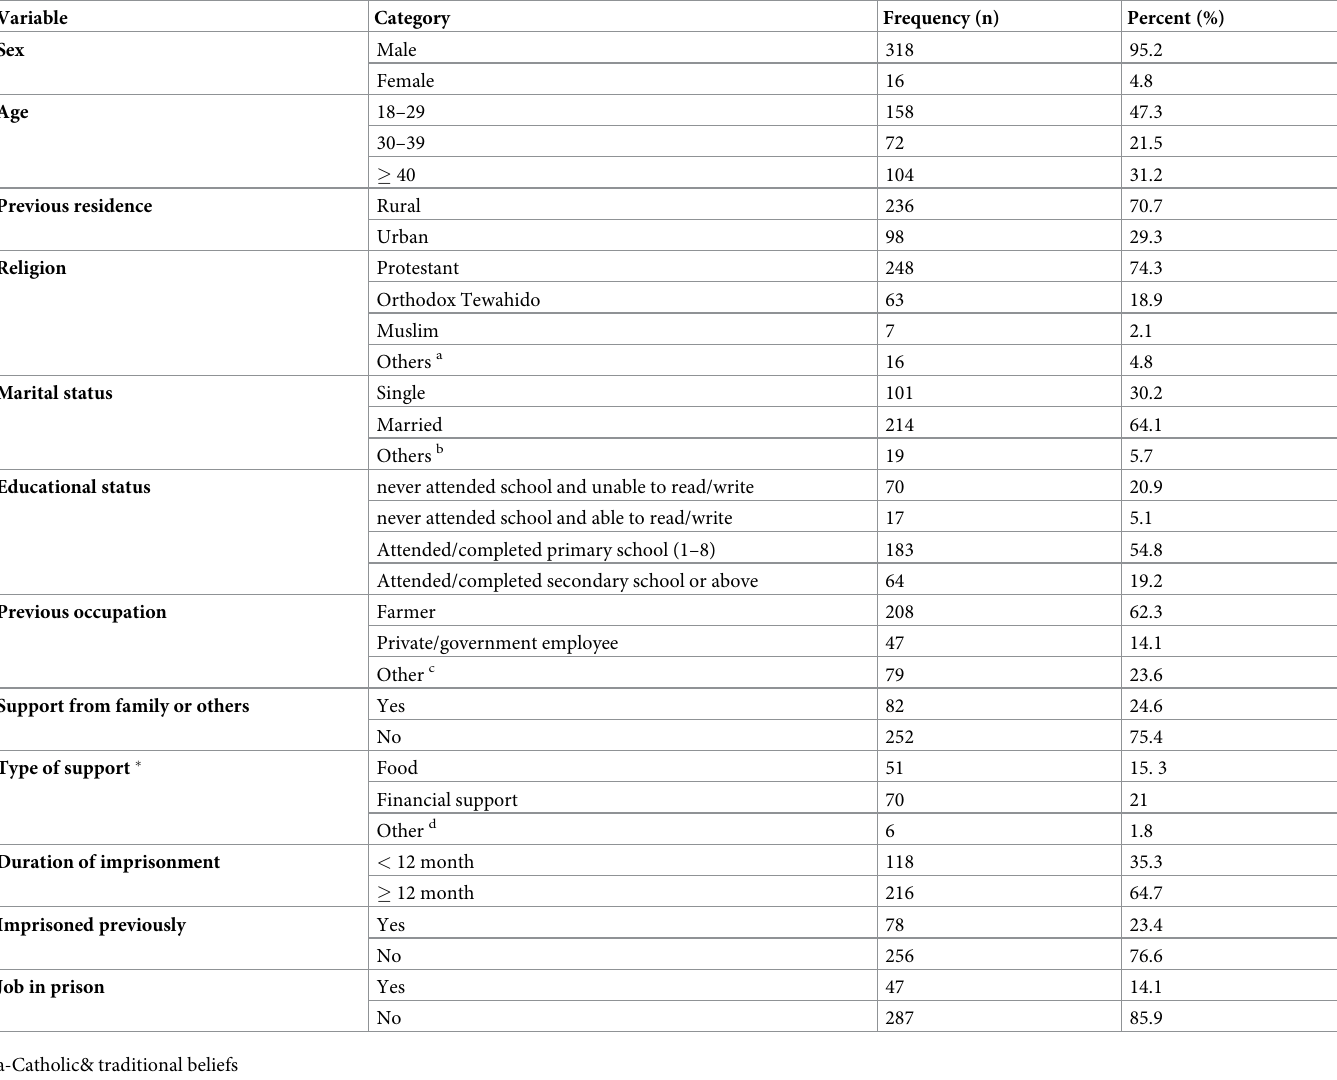
Table 1. Socio demographic and prison-related characteristics of incarcerated people in Mizan prison institute, southwest Ethiopia, 2020 (n =